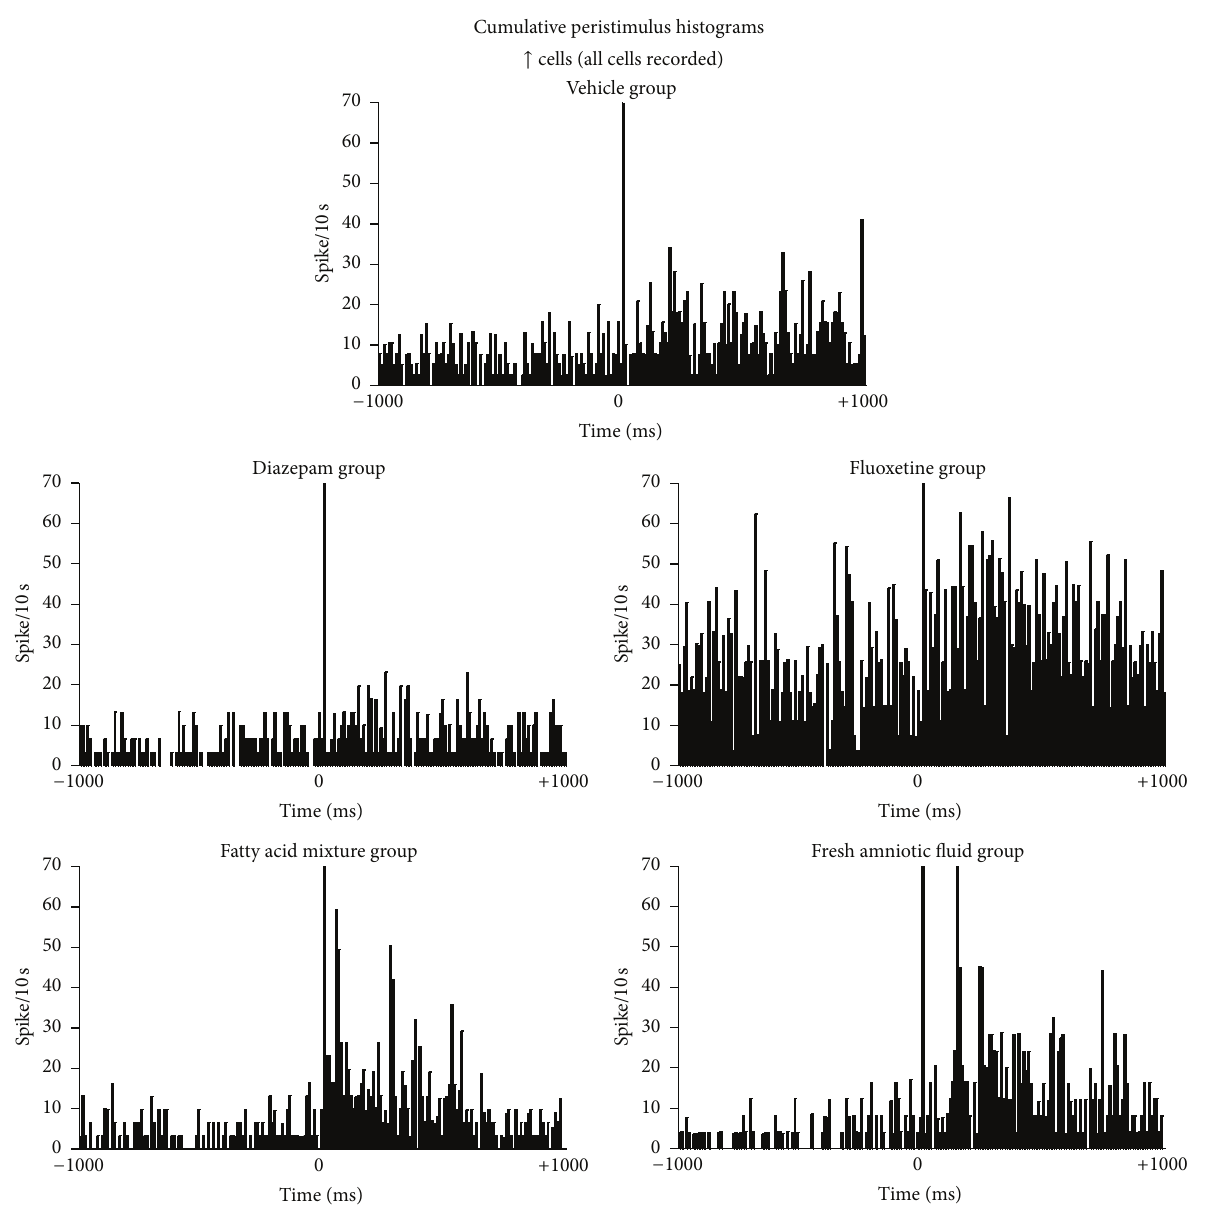
Figure 3: Cumulative peristimulus histograms. Septal neurons that responded with an increased firing rate ( ↑ cells) during amygdala stimulation are shown. Notice the qualitative change in firing in the FAT mixture and fresh human AF groups. Each histogram contains the mean firing rate (ordinate) from all recorded cells, 1000ms before and 1000ms after amygdala stimulation